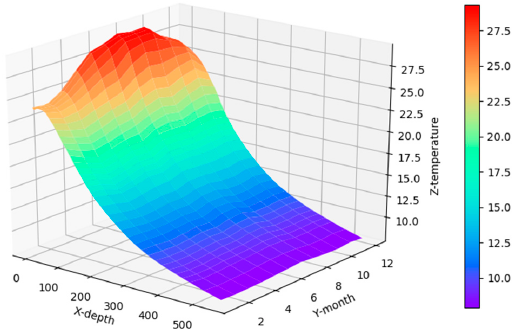
Table 2. Accuracy vs size of training